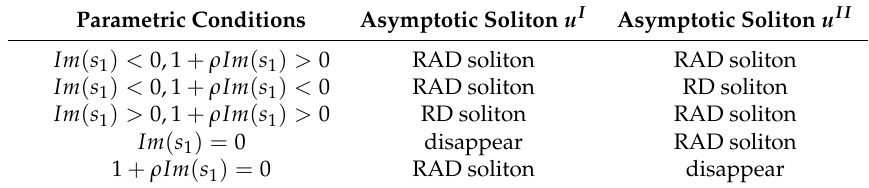
Table 2. Asymptotic patterns of the solution (26a) under different parametric